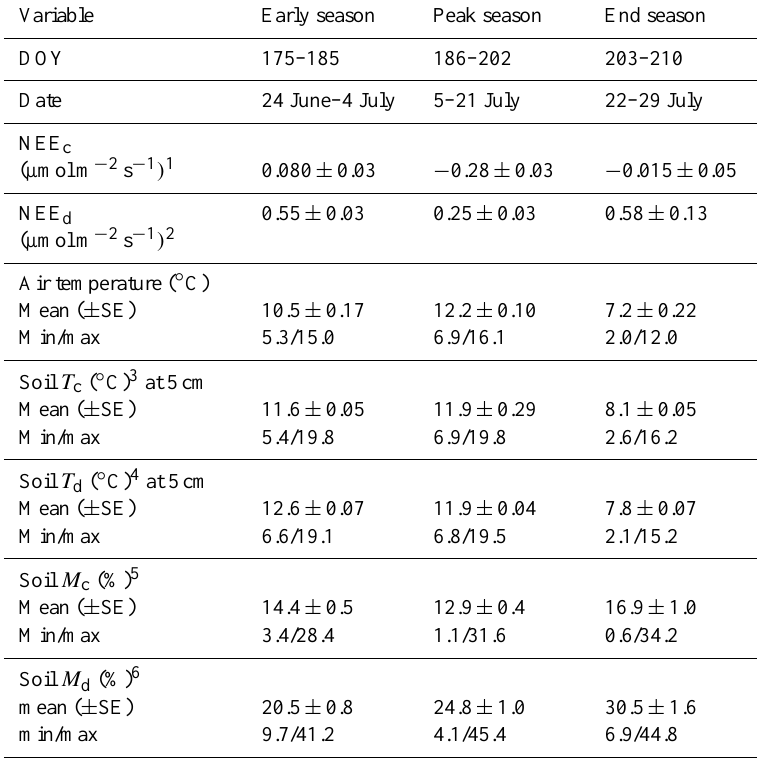
Table 1. Summary of net ecosystem exchange (NEE), soil temperatures (Soil T ) and soil moisture (Soil M ) from disturbed (subscript d) and undisturbed (subscript c) tundra, and air temperature (measured at T2) throughout the growing